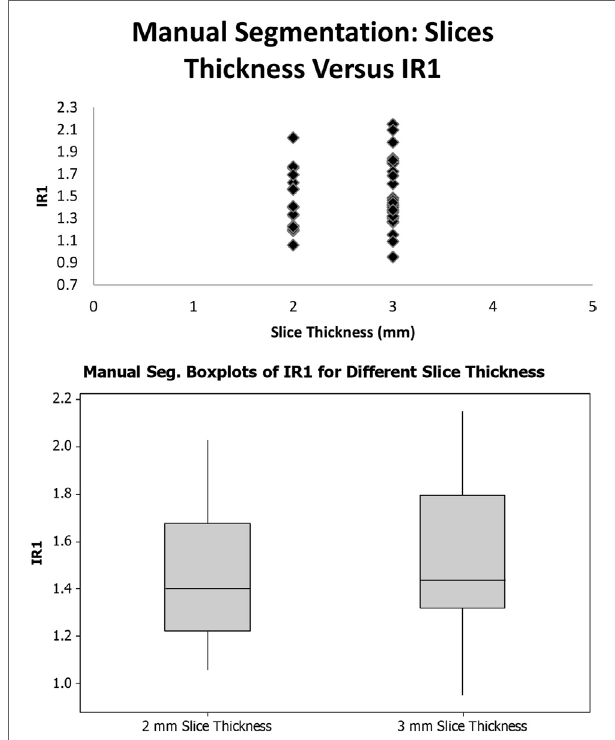
FigUre 4 | slice thickness and voxel intensity ratios (ir1)